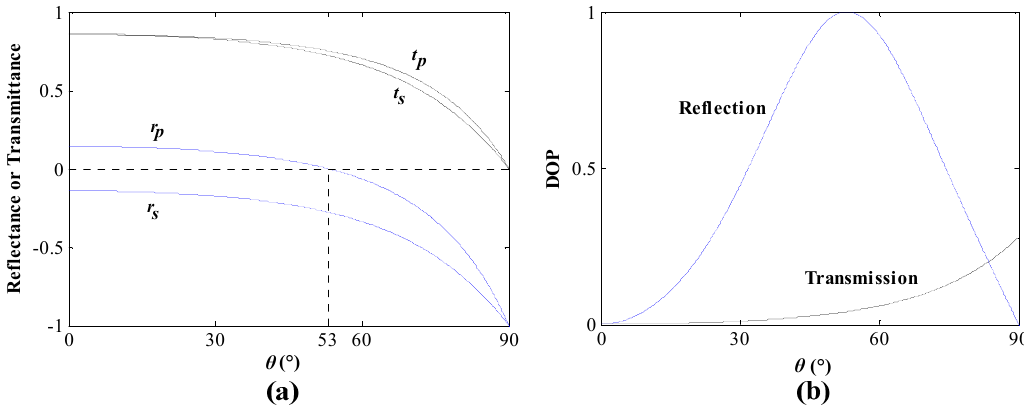
Figure 2. ( a ) The relation curves between reflection coefficients r s , r p , transmission coefficients t s , t p and incident angle θ ; and ( b ) the relation curves between the DOP of reflected and transmitted light and the incident angle.